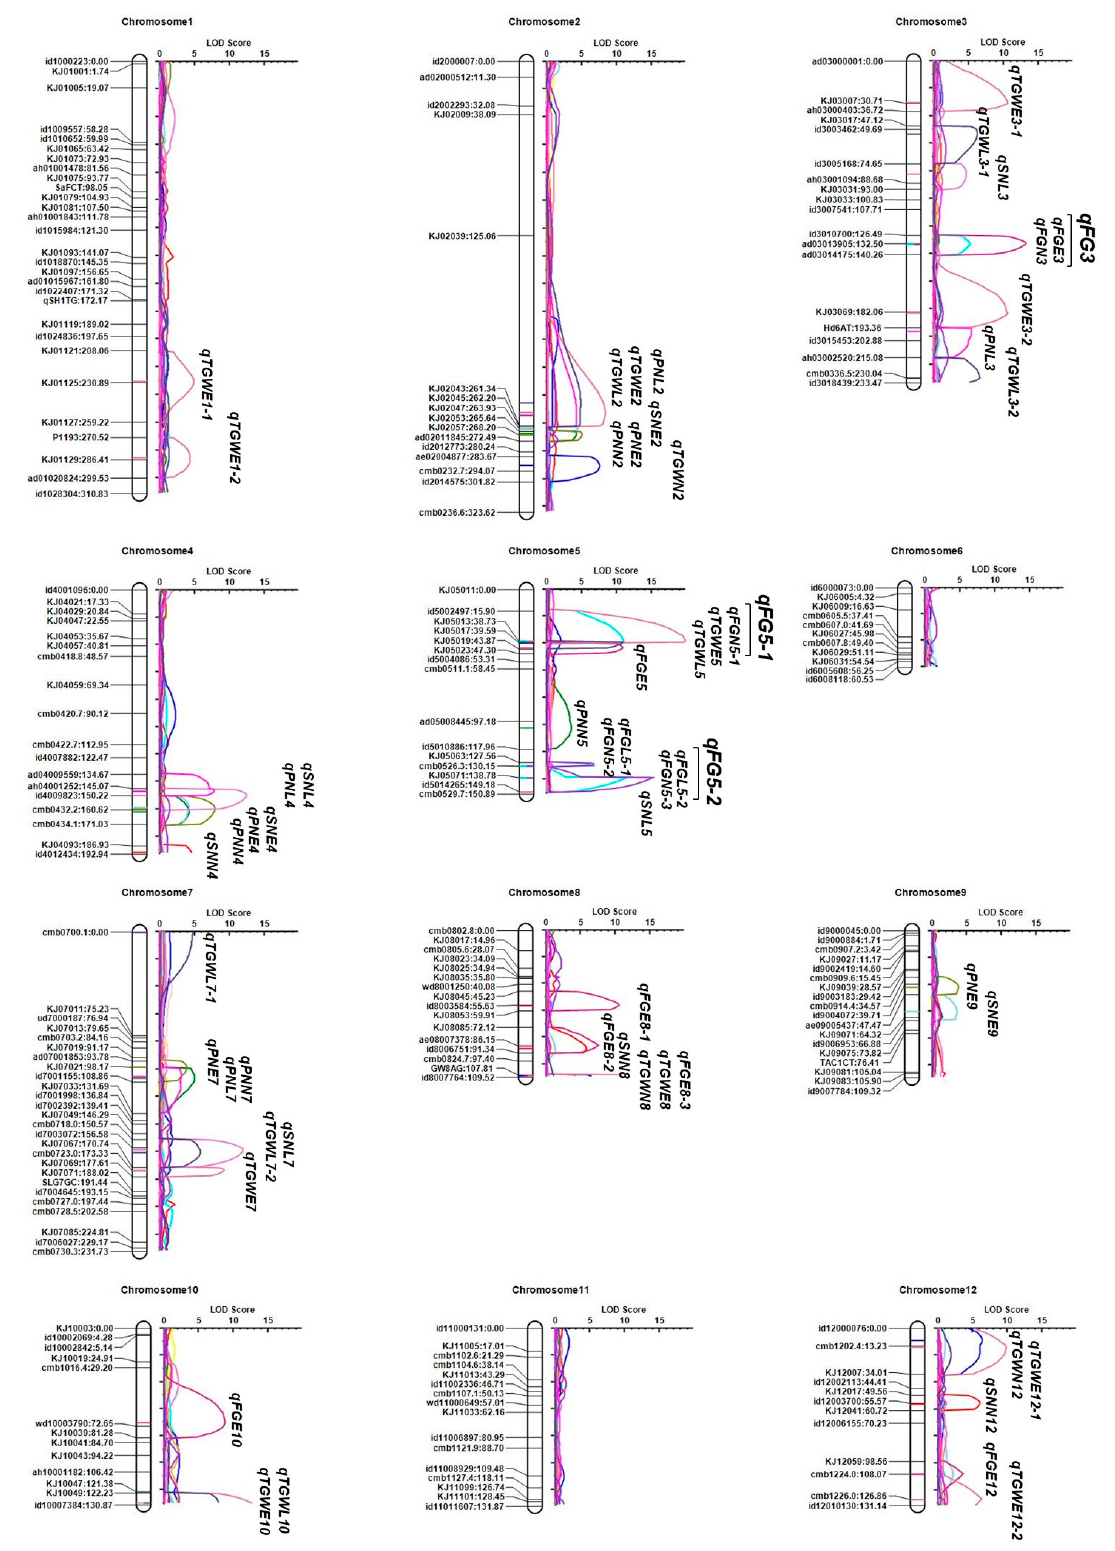
Figure 2. Linkage map of grain traits-related QTLs. qFGE3 and qFGN3 are repeatedly detected on close region of Chromosome 3 in di ff erent cultivation seasons.